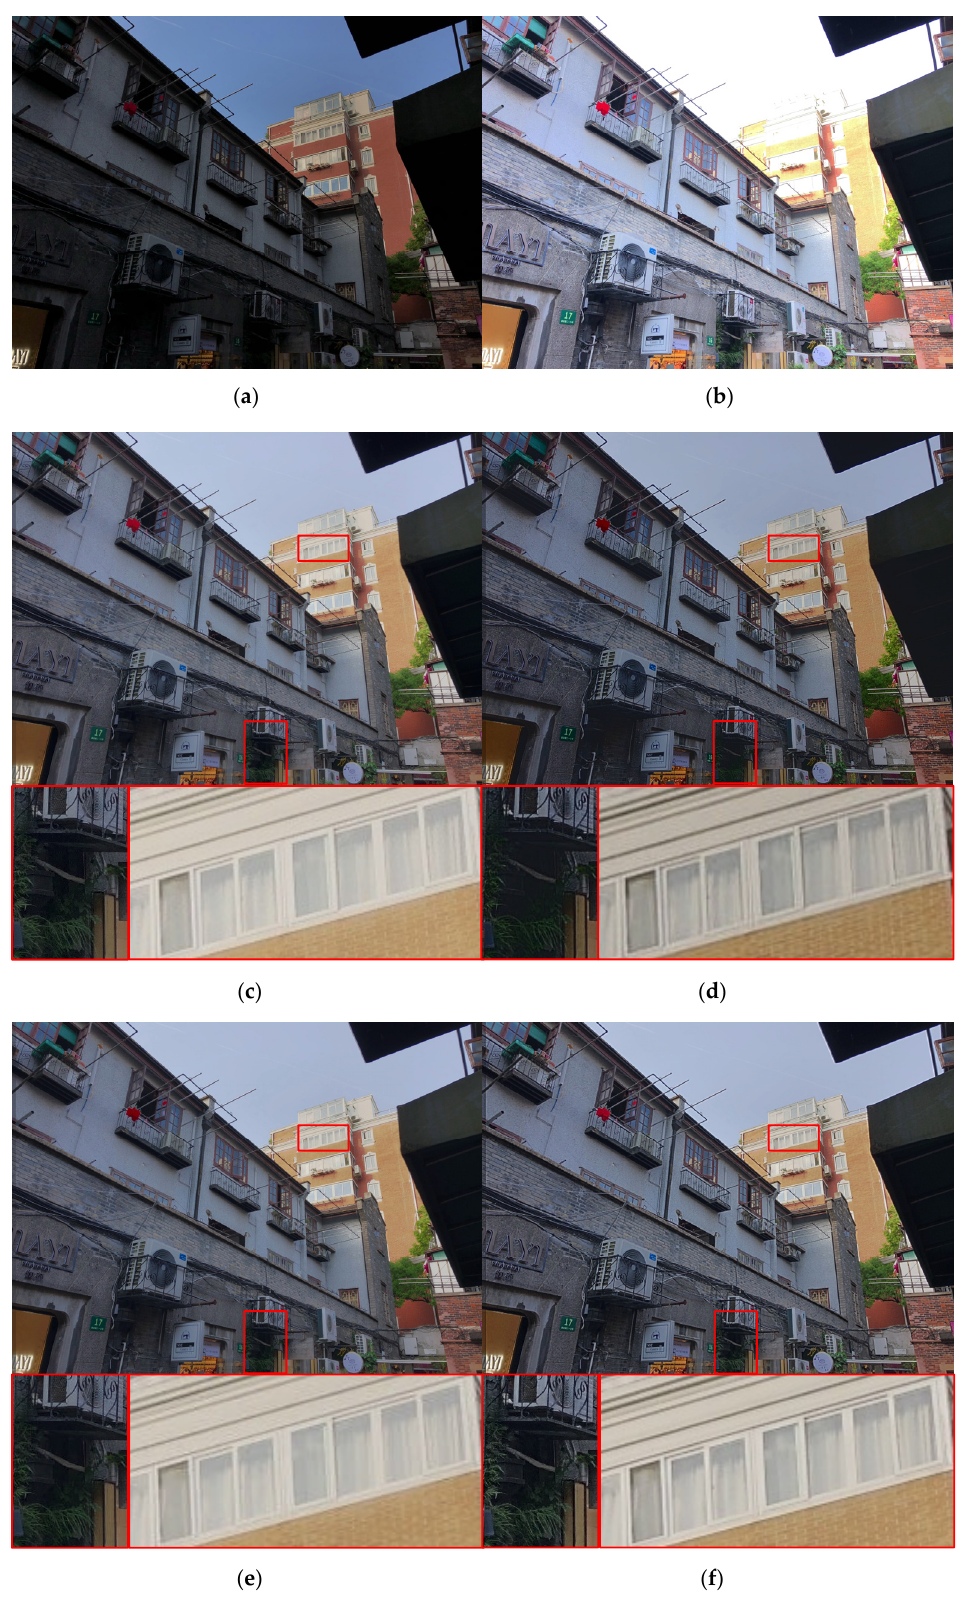
Figure 15. Input and result images (5): ( a ) Under-exposed image, ( b ) Over-exposed image, ( c ) DenseFuse, ( d ) U2Fusion, ( e ) TransMEF, ( f ) Proposed model.